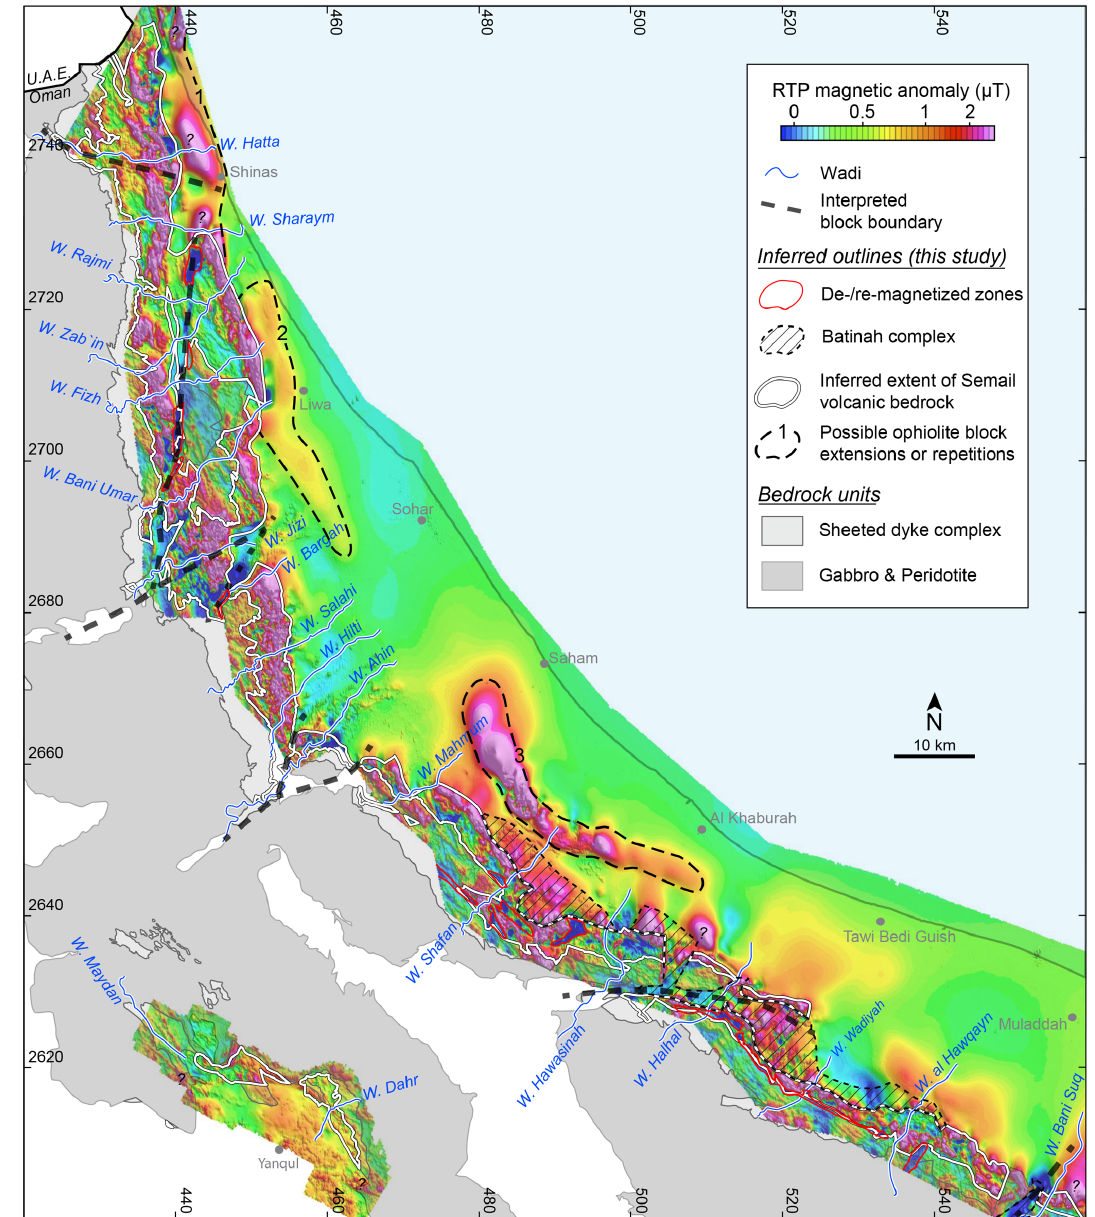
Figure 10. Reduced-to-pole (RTP) magnetic anomalies for the Batinah coast and Yanqul area (Isles and Witham, 1993), marked with our interpretations of the block boundaries, the extent of volcanic bedrock, structurally controlled re- or de-magnetised features, the potentially magnetic Batinah complex modified after BRGM (1986a, b) and Woodcock and Robertson (1982), and possible repetitions or extensions of ophiolite blocks (numbered) visible in the RTP map, supported by the gravity interpretations of Shelton (1990). The Batinah RTP map and remagnetised features are viewable as separate layers in the supplementary Geospatial PDF. The Batinah RTP base map is reproduced with permission from the Public Authority for Mining, Sultanate of Oman, who reserve all